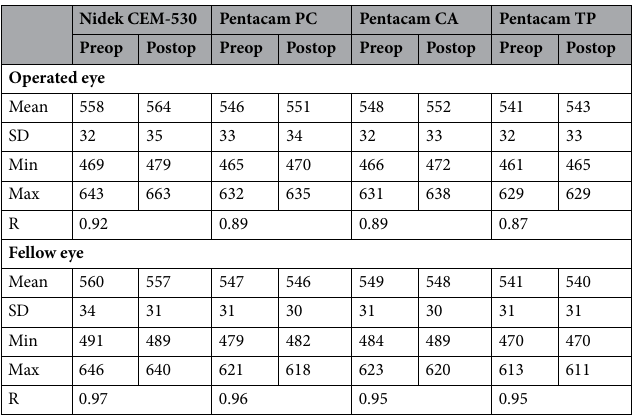
Table 1. Preoperative and postoperative CT values for operated and fellow eye. PC pupil center, CA corneal apex, TP thinnest point, SD standard deviation, R Pearson correlation